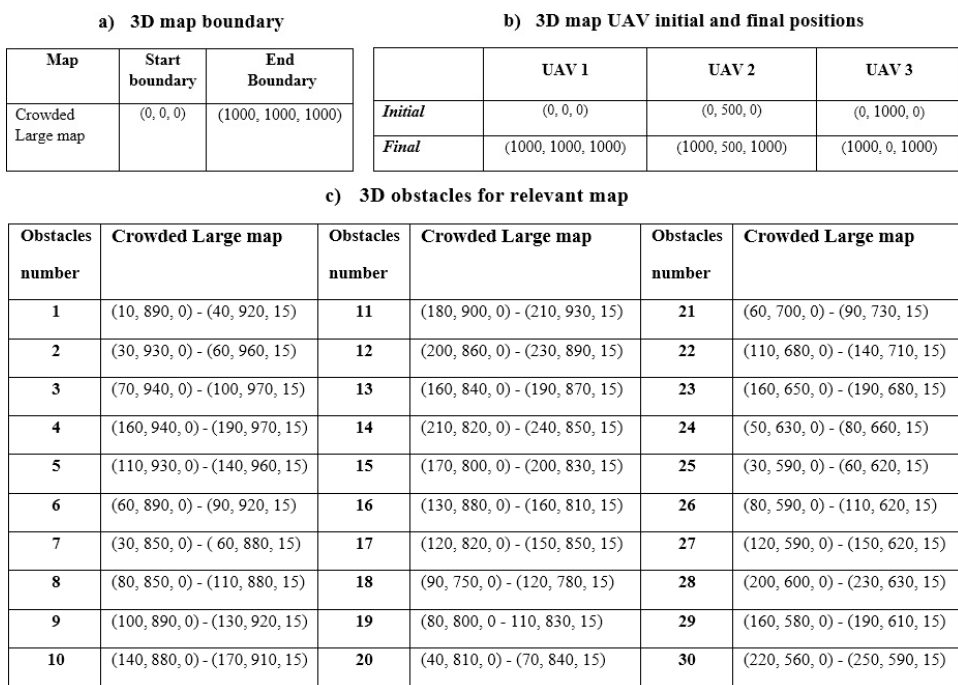
Figure 2. The randomly created and optimized trajectory. ( a ) Randomly Created Path; ( b ) Opti- mized Created Path.